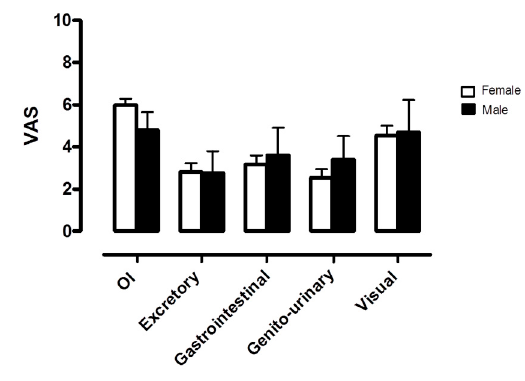
Figure 4. Autonomic symptom assessment at baseline by modified VAS according to gender.